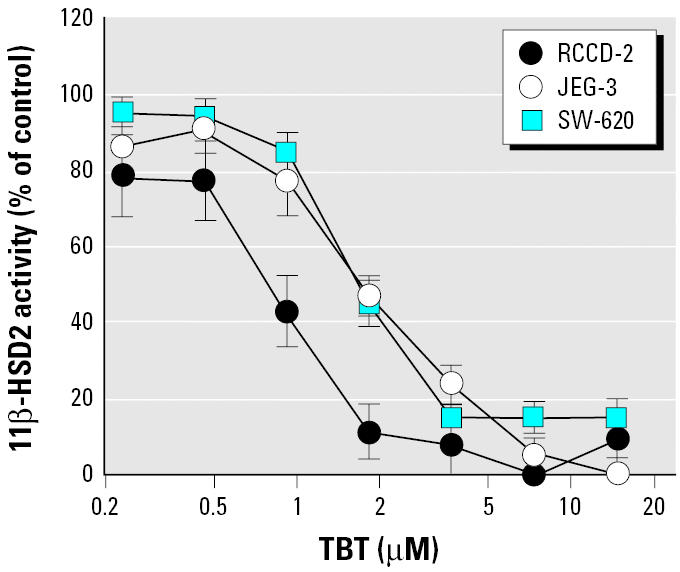
Dose–response curves for TBT-induced inhibition of 11β-HSD2 in intact cells expressing endogenous 11β-HSD2. RCCD-2, rat renal cortical collecting duct cell line; JEG-3, human choriocarcinoma cell line; SW-620, human colon adenocarcinoma cell line. Details on culture conditions and activity assay in intact cells are given in “Materials and Methods.”